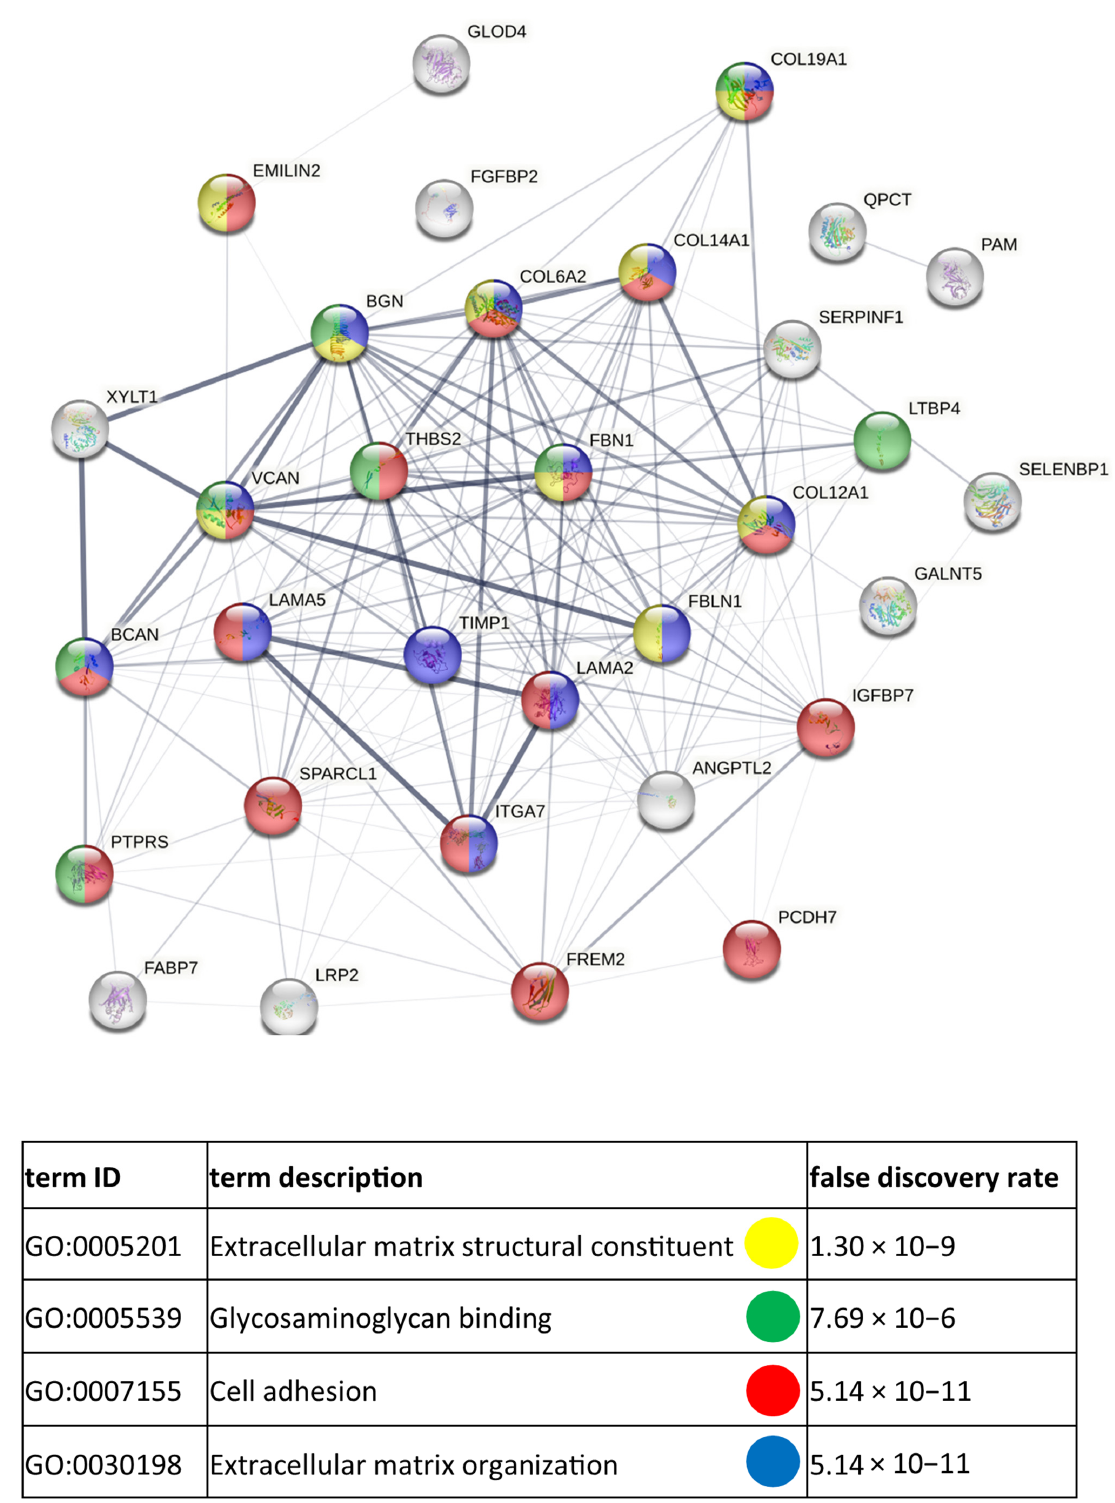
Figure A7. Diagram of functional protein association networks prepared with the use of STRING v. 11.0 software for proteins identified in WM266-4-derived exosomes but not found in any replicates of WM115-derived exosomes. The selected, strongly represented pathways are presented as an interactome. A complete analysis is presented in Supplementary Data